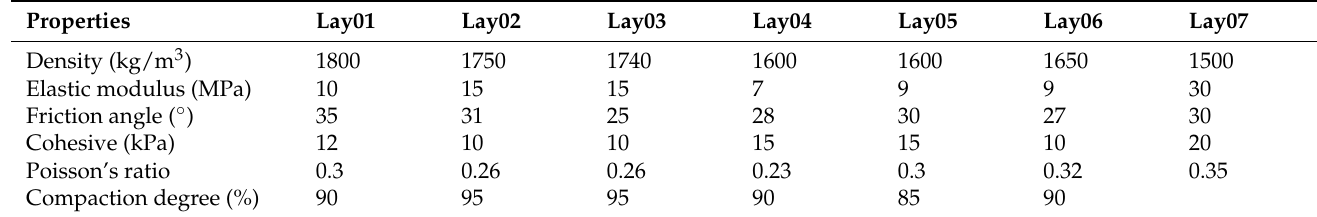
Table 2. Mechanical parameters of each layer of the backfill in the numerical simulation.